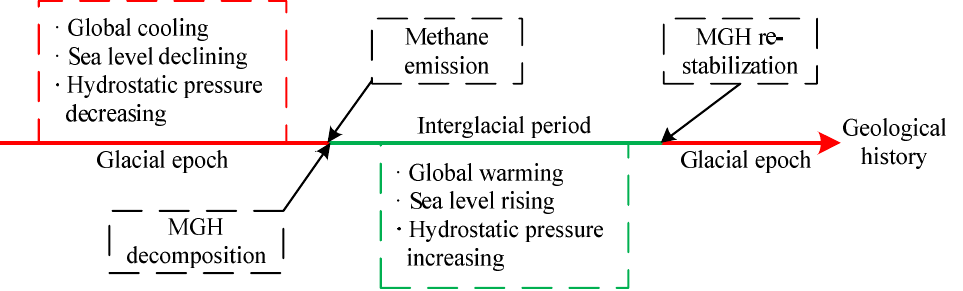
Figure 6. Relationship between gas hydrate decomposition and climate change.